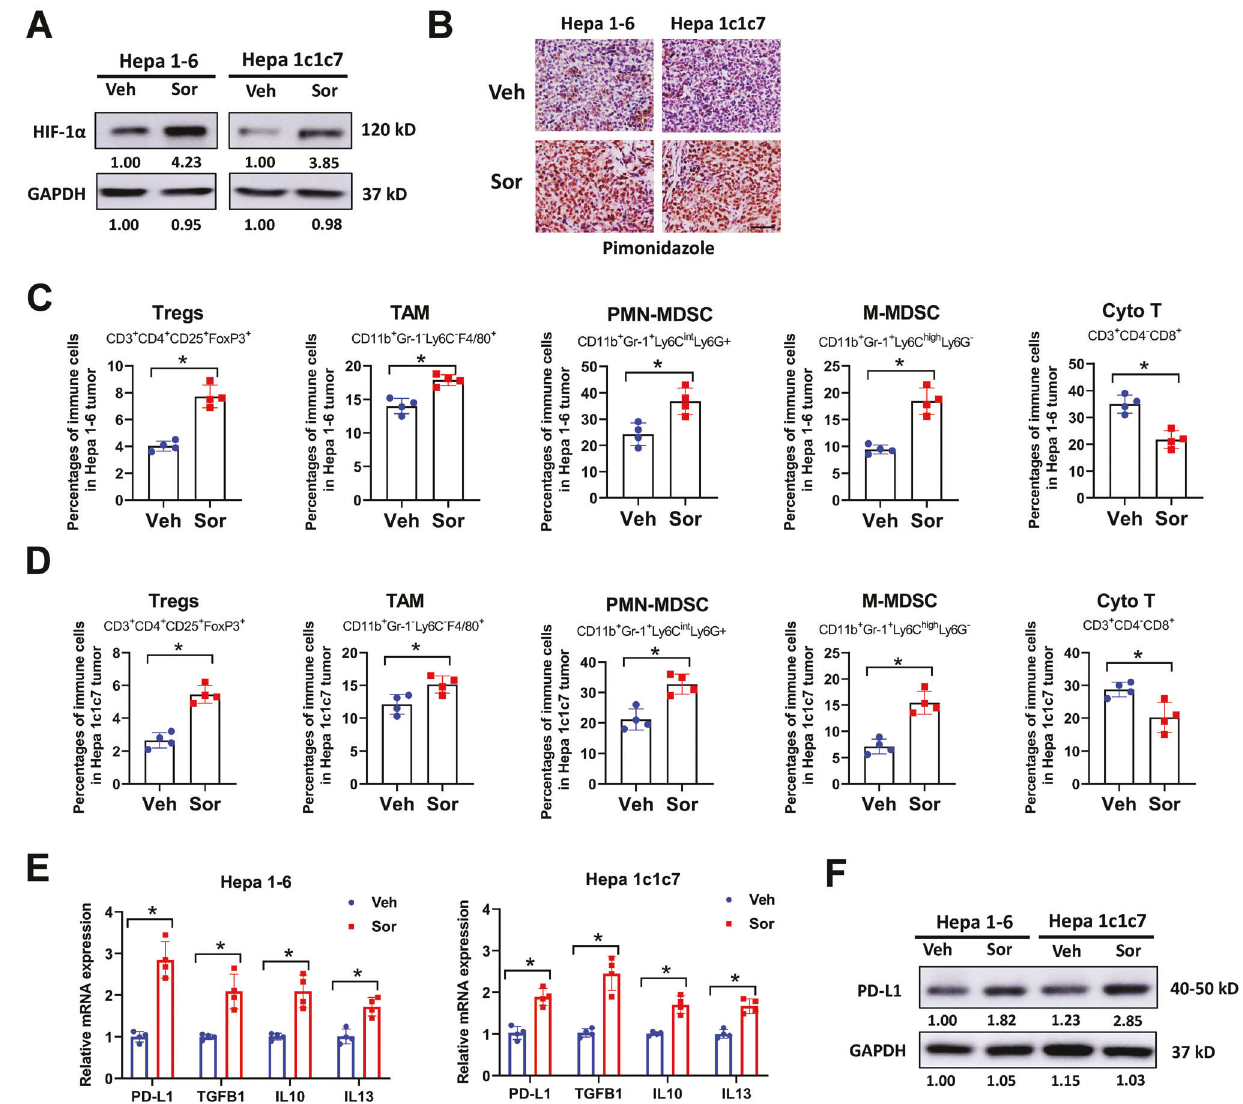
Fig. 1 Sorafenib treatment increases intratumoral hypoxia and alters HCC microenvironment towards an immune-resistant state in mouse models. A , B orthotopic Hepa 1-6 and Hepa 1c1c7 tumors were treated with sorafenib or vehicle control for three weeks, then collected protein lysates for western blot ( A ) or tissue samples for Pimonidazole staining ( B ). C , D in fi ltrating immune cells in orthotopic Hepa 1-6 and Hepa 1c1c7 tumors treated with sorafenib or vehicle control were evaluated by fl ow cytometry. CD3 + CD4 + CD25 + FoxP3 + Treg, CD11b + Gr-1 − Ly6C − F4/80 + TAM, CD11b + Gr-1 + Ly6C int Ly6G + PMN-MDSC, CD11b + Gr-1 + Ly6C high Ly6G - M-MDSC and CD3 + CD4 - CD8 + Cyto T cells were evaluated. E relative expression of PD-L1, TGFB1, IL10, and IL13 in orthotopic Hepa 1-6 and Hepa 1c1c7 tumors was evaluated by qRT-PCR. F protein expression of PD-L1 in orthotopic Hepa 1-6 and Hepa 1c1c7 tumors was evaluated by western blot. All assays were done with at least three repeats. Data were shown as mean ± s.d., * P <